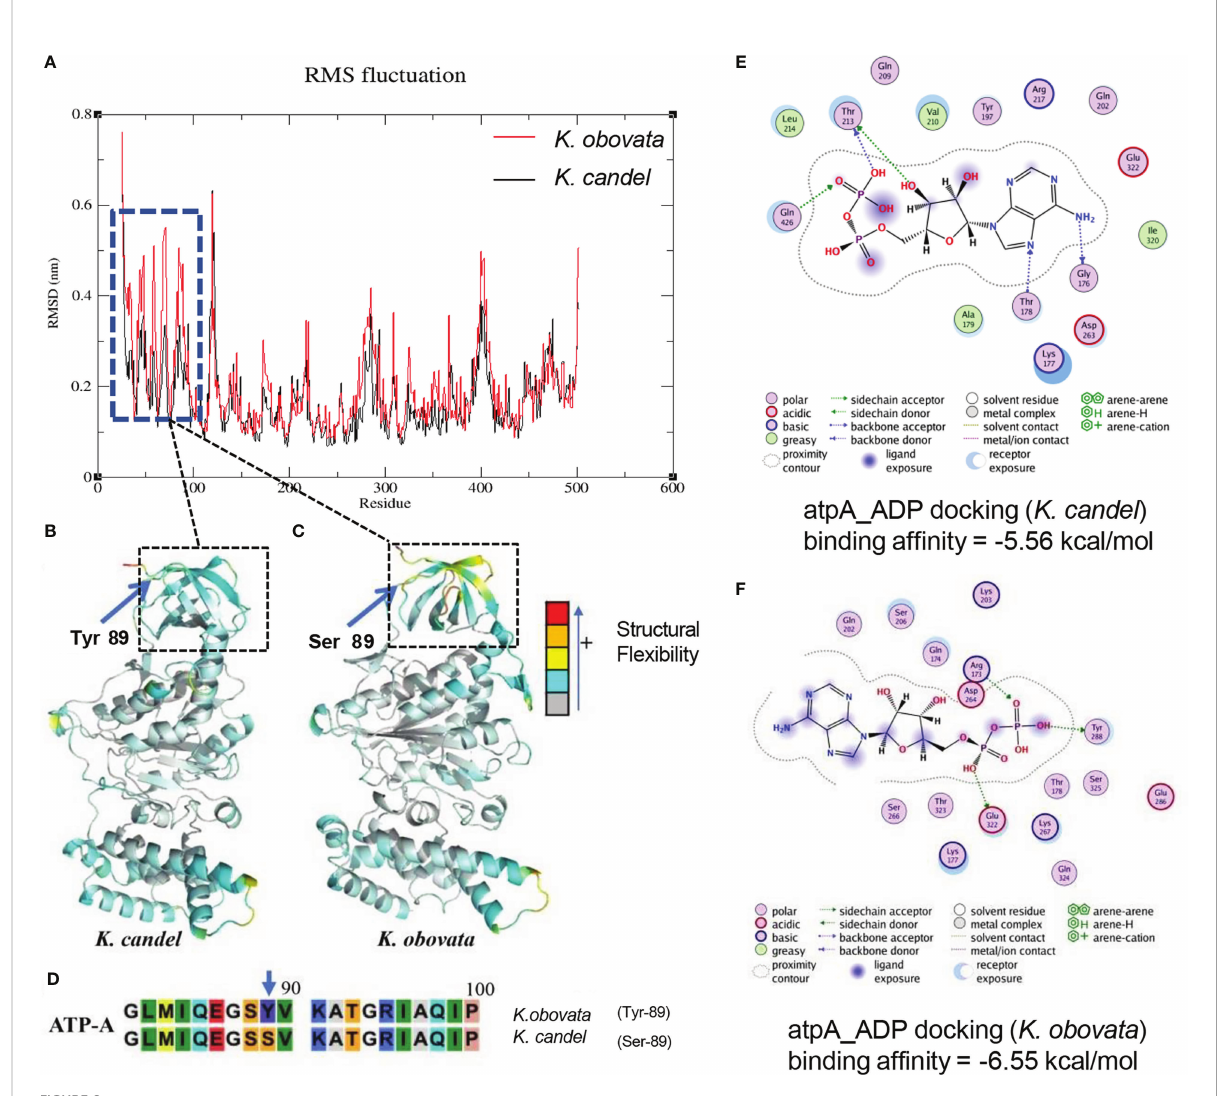
FIGURE 8 The predicated 3D structural modeling and molecular dimnamics simulation of the ATP-A protein. By setting different colors (gray to blue to yellow to orange to red) according to the b-factor values, the color in the structure is closer to red, the more fl exible the structure. (A) The conformational variations of protein amino acid residues during the molecular dynamics simulation process showing the distinct difference in the region from 26aa to 96aa. (B) The 3D model of ATP-A protein for K . candel . (C) The 3D model of ATP-A protein for K . obovata . (D) The mutation at the site of the 89 aa of ATP-A protein between K . candel and K . obovata . (E) Molecular dimnamics simulation of ATP-A protein and ligand ADP docking exhibuted by binding af fi nity for K . candel (E) and K. obovata (F)